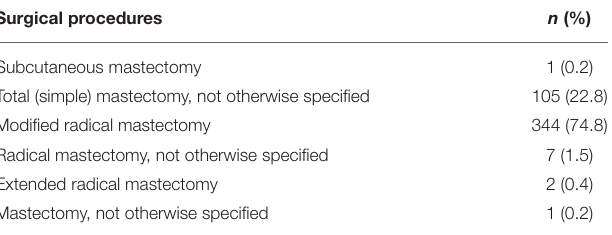
TABLE 2 | The surgical procedures of the 460 patients. Surgical procedures